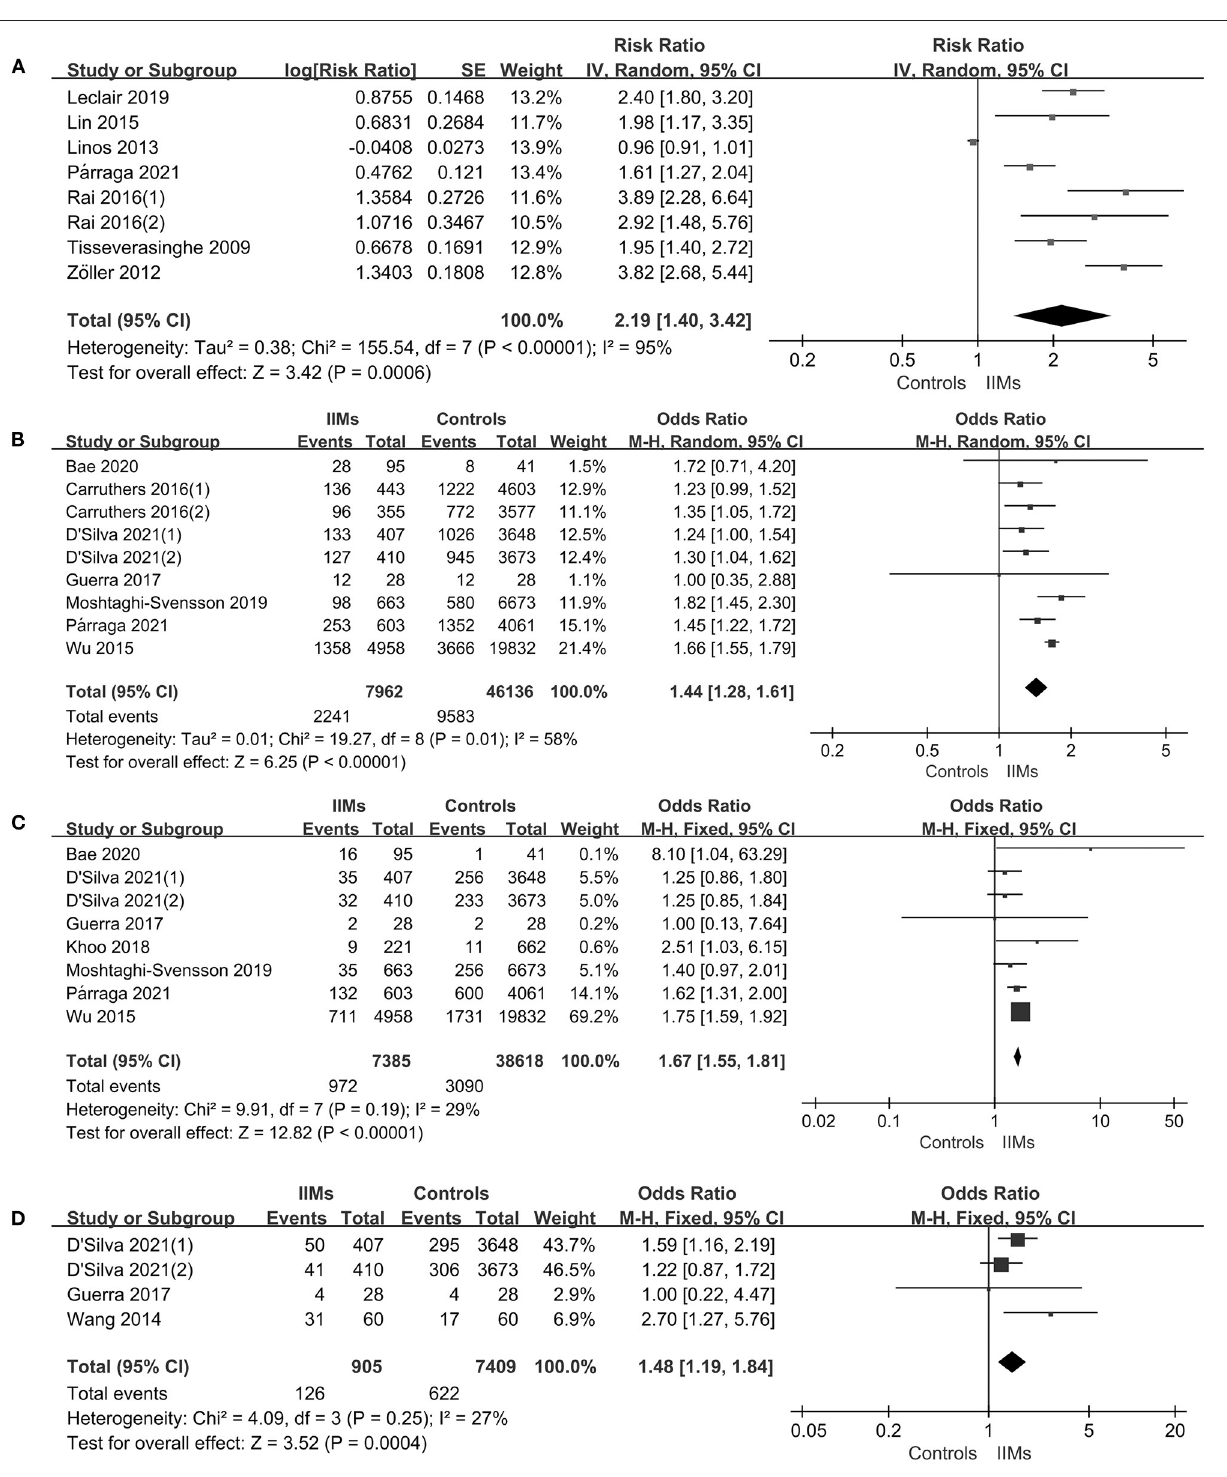
Frontiers in Medicine |